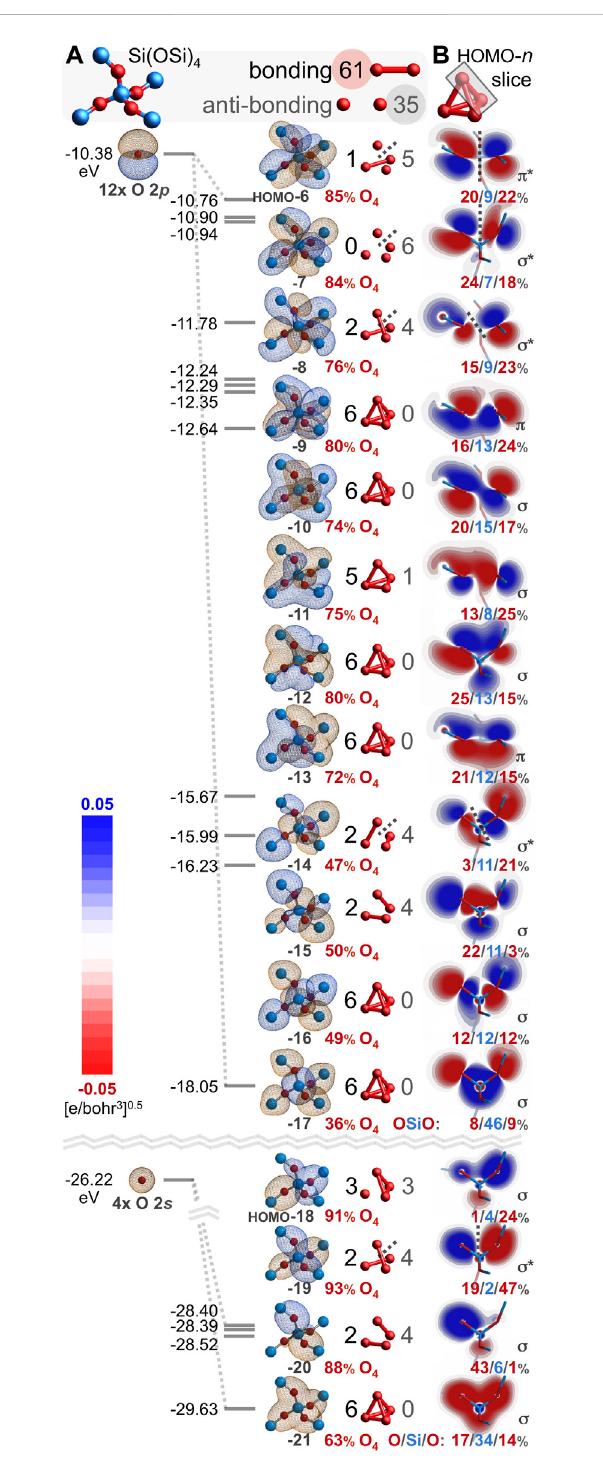
FIGURE 4 Oxygen-basedvalencemolecularorbitals(IsoValue=0.01[e/bohr 3 ] 0.5 ) for Si(OSi) 4 excised from quartz silica (A) . Bonding and anti-bonding O-O interactionsaretabulated along withthe oxygen atomicorbital contribution (red). Slices for each HOMO- n along the upper right O-O axis reveal excess bonding (11; σ and π ) vs. anti-bonding (5; σ * and π *) interactions (B) . The corresponding O/Si/O atomic orbital contributions reveal the greatest O-O covalency for HOMO-13 through